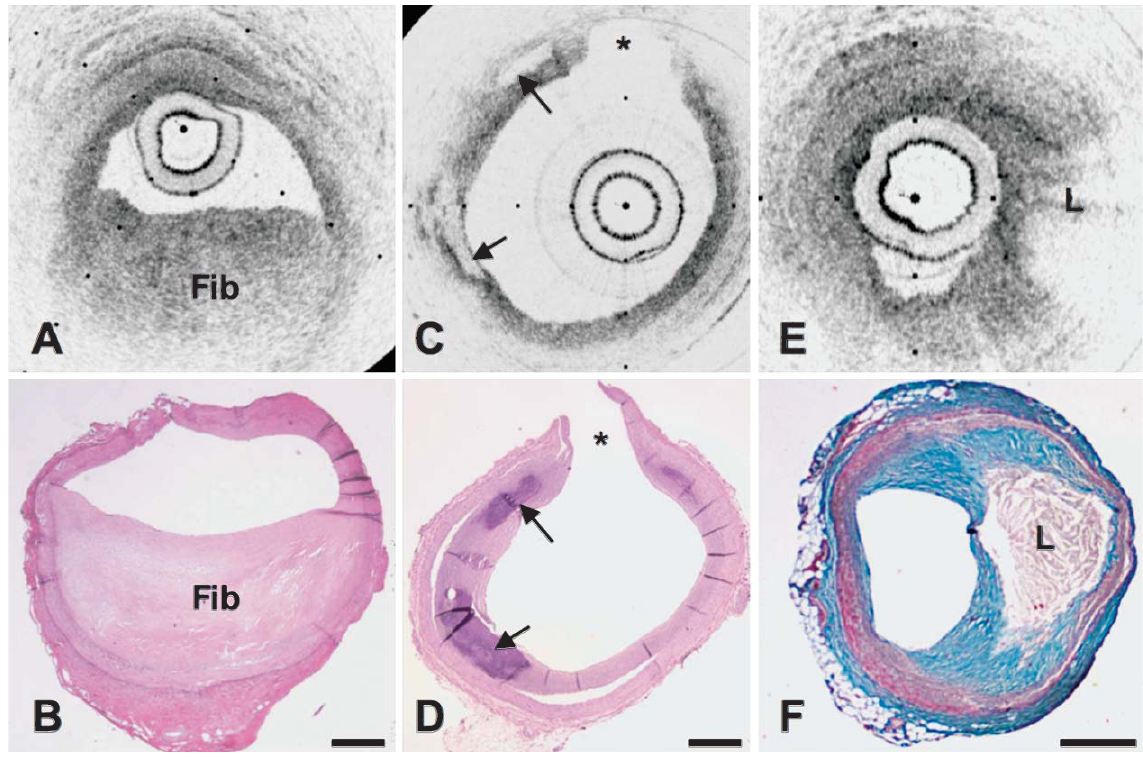
Fig. 4. OCT images and corresponding histology for (A, B) fibrous, (C, D) calcific, and (E, F) lipid-rich plaque types. Abbreviations: Fib, fibrous plaques; L, lipid-rich regions. Arrows indicate calcific regions. Asterisks show correlating features. Scale bars represent 500 (cid:1) m. Figure used with permission from